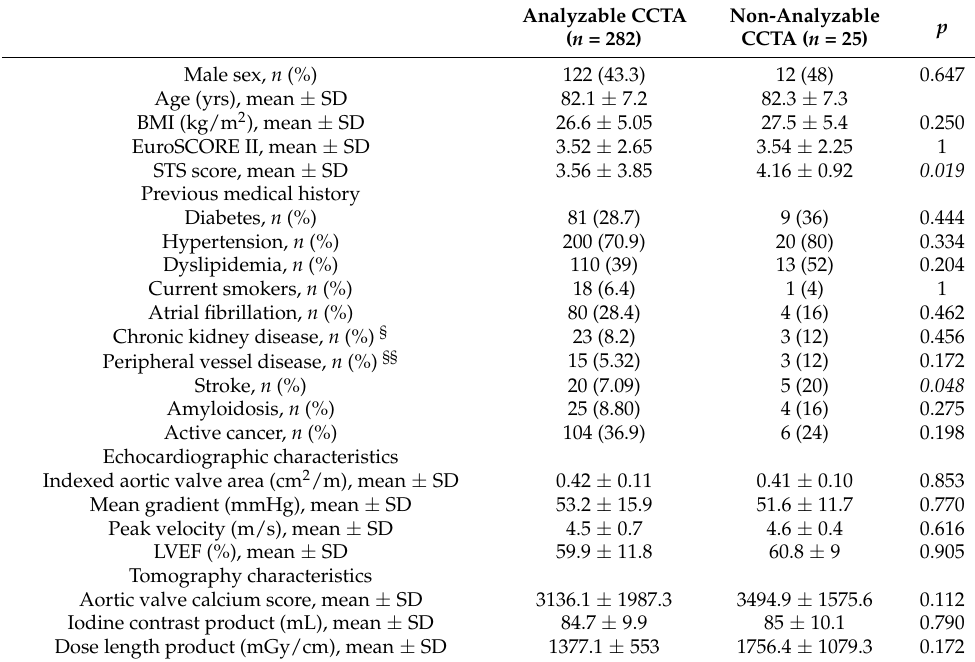
Table 1. Population characteristics ( n =